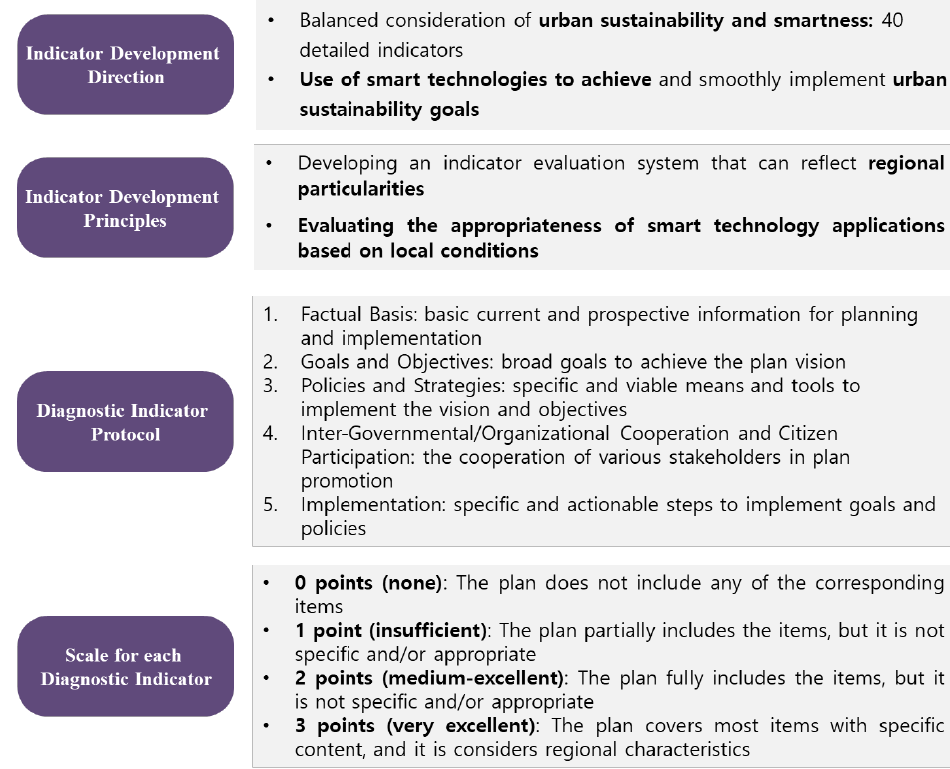
Figure 4. Principles and direction of smart sustainable city evaluation and diagnosis indicators. Source: [57].